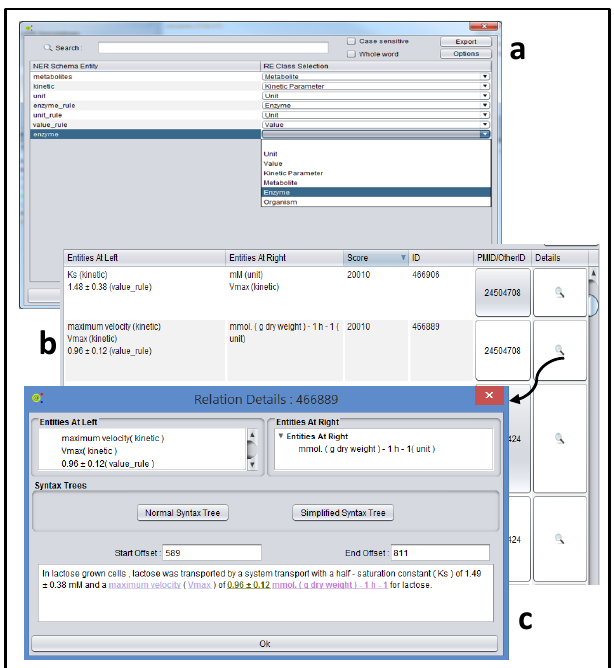
Figure 8: Kinetic RE GUIs: second Input (a) and two Output Views (b and